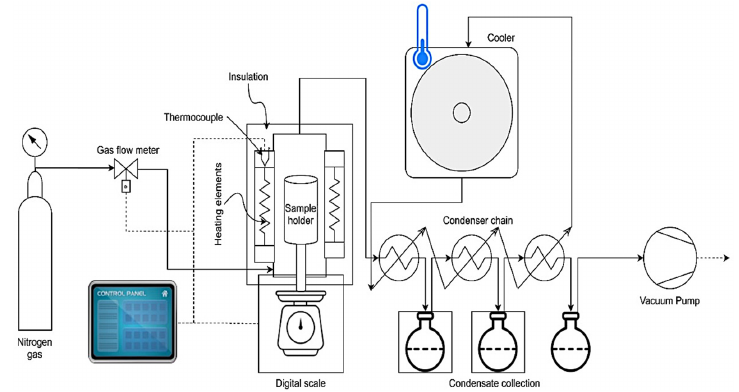
Figure 1. Schematic representation of the custom-made fixed-bed fast pyrolyzer.